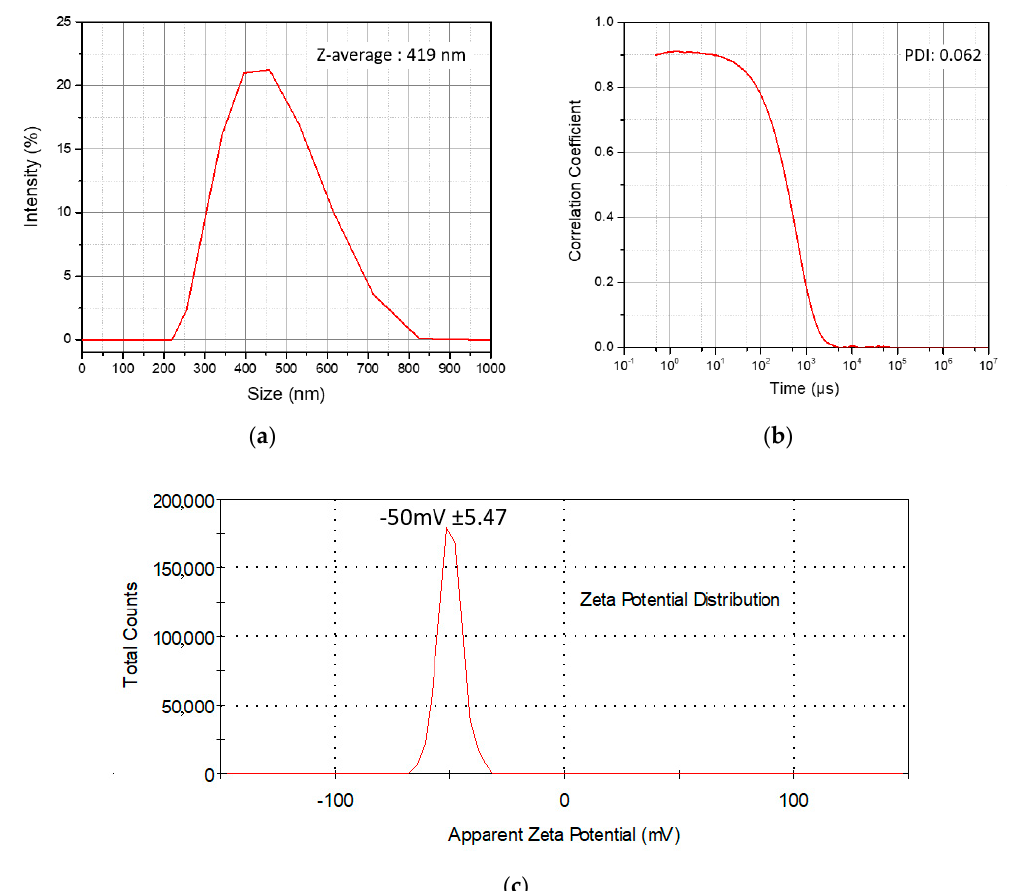
Figure 3. DLS measurements of the PMAA-co-MBA microspheres ( a ) average hydrodynamic radius size distribution; ( b ) correlation function diagram; ( c ) ζ -potential-surface charge distribution.